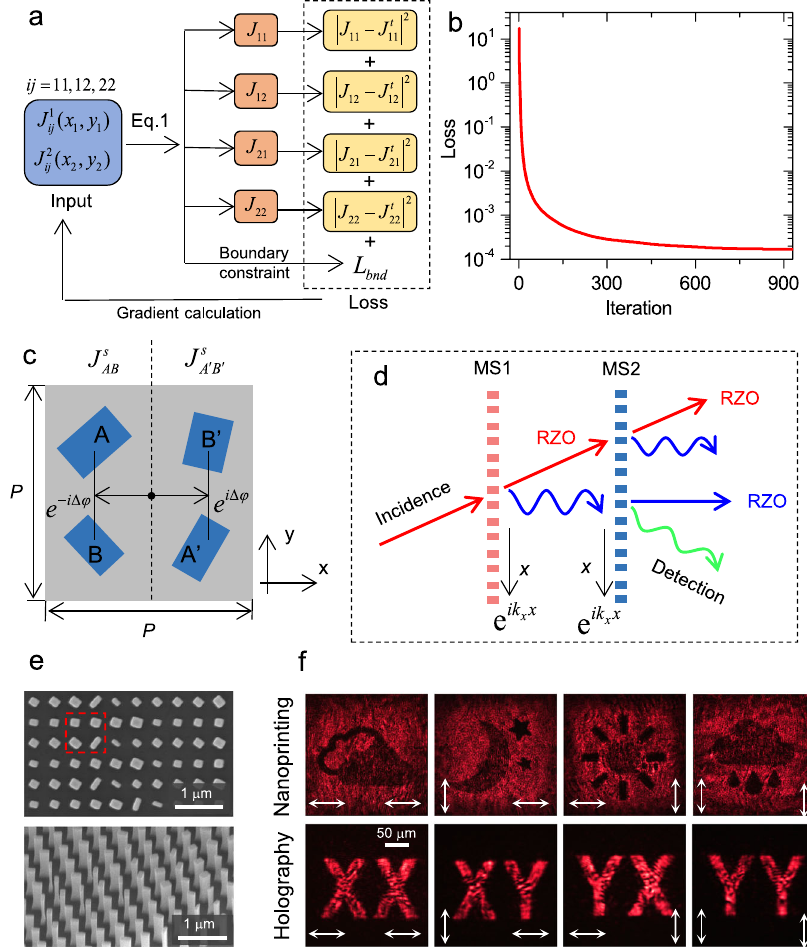
Fig.2|DesignofJonesmatrixwitheightDOFsandmeasurementresults.a Flow chart of the gradient descent optimization algorithm for design of Jones matrix with eight DOFs. The input variables are the Jones matrix components of the two single layer metasurface ( J 1 ij ð x 1 , y 1 Þ , J 2 ij ð x 2 , y 2 Þ , ij =11, 12 (21), 22). The de fi ned loss includes two parts: the mean of the absolute squared differences of EQJM com- ponents between the prediction ( J ij ) and target ( J t ij ), and a boundary constraint loss L bnd . b Lossvalueasa function of the iteration numberinthe gradient descent optimization algorithm. c Unit cell of the single layer metasurface to construct JonesmatrixwithsixDOFs.Eachunitcontainsoffourdielectricnanopillars,andthe two sets of nanopillars AB and A ’ B ’ can individually and independently construct Jones matrix with six DOFs. Under oblique incidence or oblique scattering, detour phases of e (cid:3) i Δφ and e i Δφ are imposed on the two sets of nanopillars AB and A ’ B ’ . To compensate the detour phases,the Jonesmatrixesof the two setof nanopillarsare chosenas J s AB = e i Δφ J and J s A 0 B 0 = e (cid:3) i Δφ J toconstructively generate the designedJones